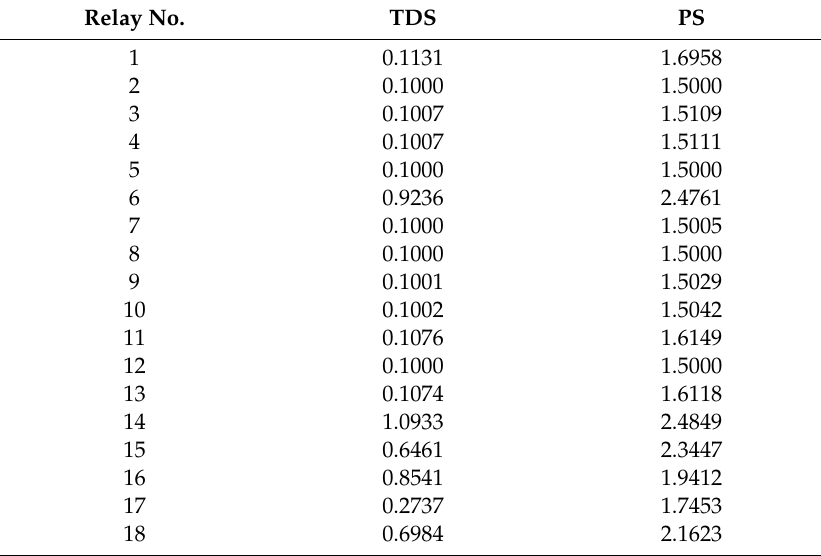
Table 17. Optimal TDS for the IEEE 30-bus